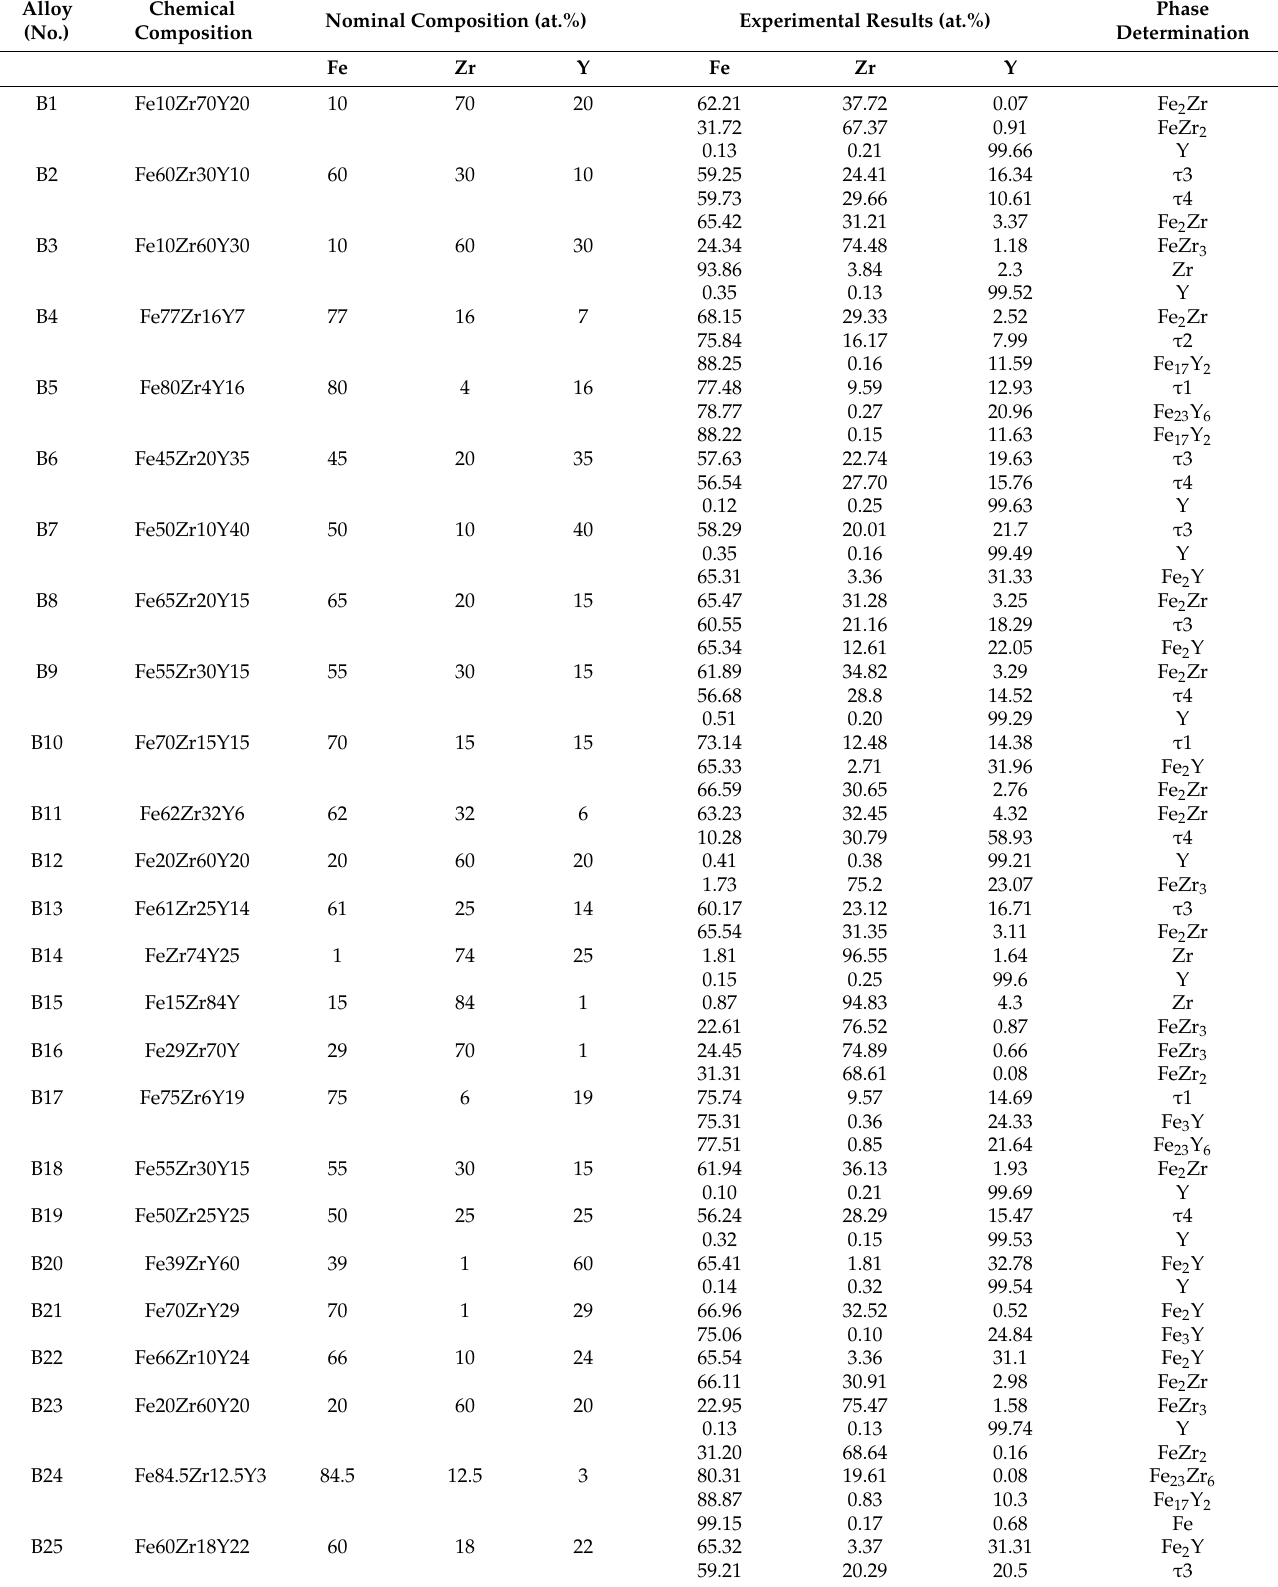
Table 3. Constituent phases and compositions in the annealed Fe-Zr-Y alloys at 1073 K for 60